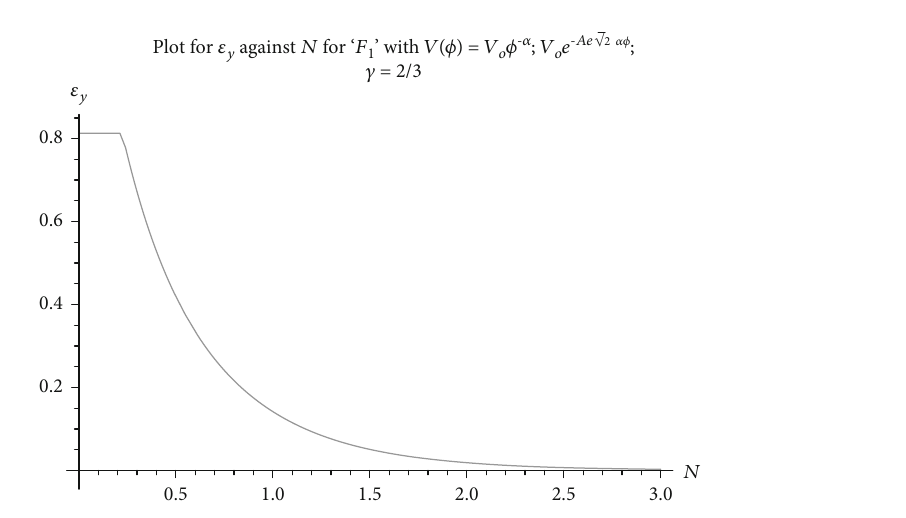
Figure 17: Shows the variation of perturbations along the x -axis ( ϵ power law forms.